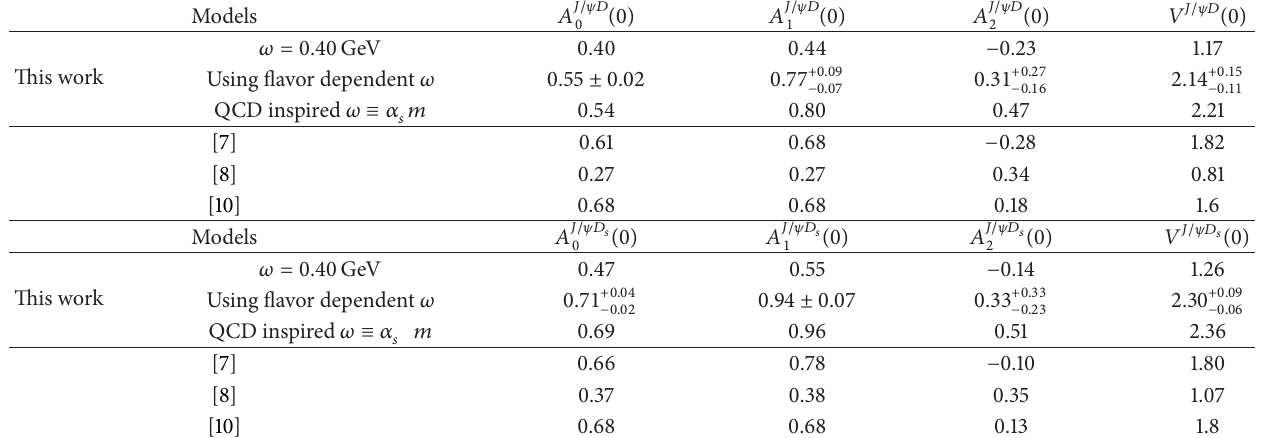
Table 1: Form factors of 𝐽/𝜓 → 𝑃